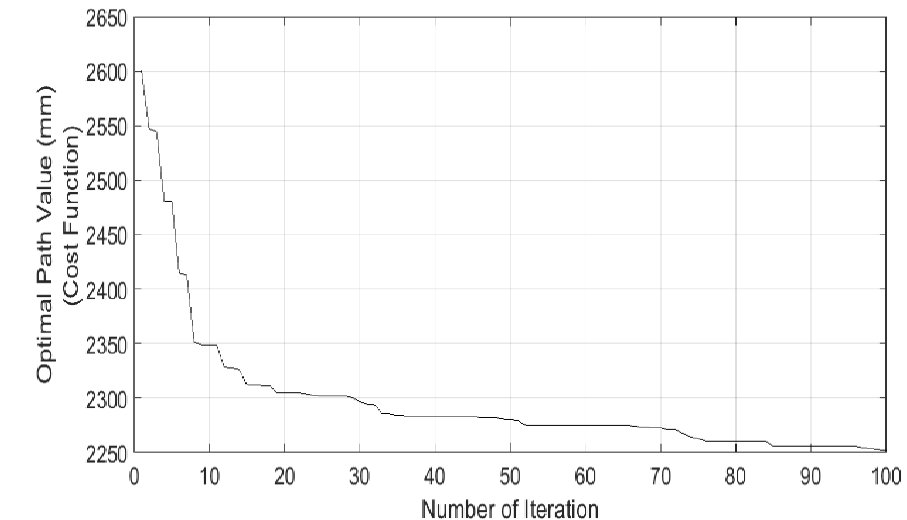
Fig. 4. Path Found by GWO Algorithm for Case 1